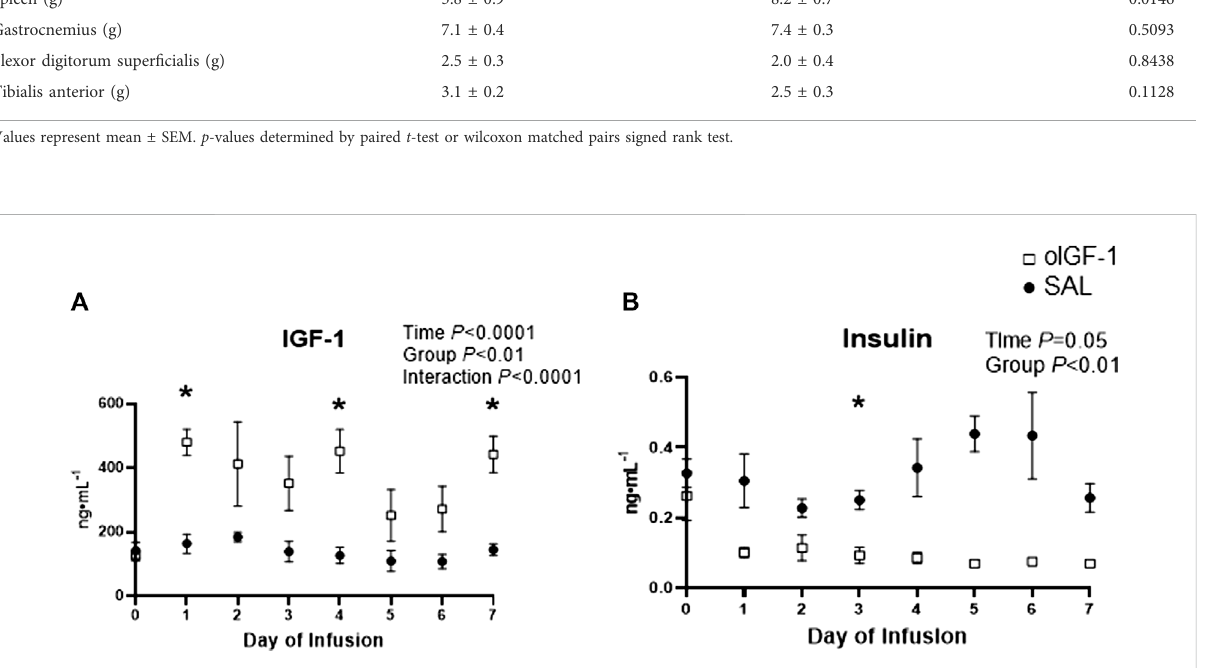
FIGURE 5 Fetal concentrations of IGF-1 and insulin during chronic recombinant ovine IGF-1 (oIGF-1) infusion. Fetal plasma concentrations of (A) IGF-1 and (B) insulin in fetal sheep that received either oIGF-1 (n = 6, open squares) or saline (SAL, n = 6, closed circles) infusion for 1 week. Signi fi cant effects by mixed model ANOVA [time, group (oIGF-1,SAL), and interaction] are indicated. *Indicates signi fi cantly different( p ≤ 0.05)betweenoIGF-1 and SAL by Bonferroni ’ s post hoc